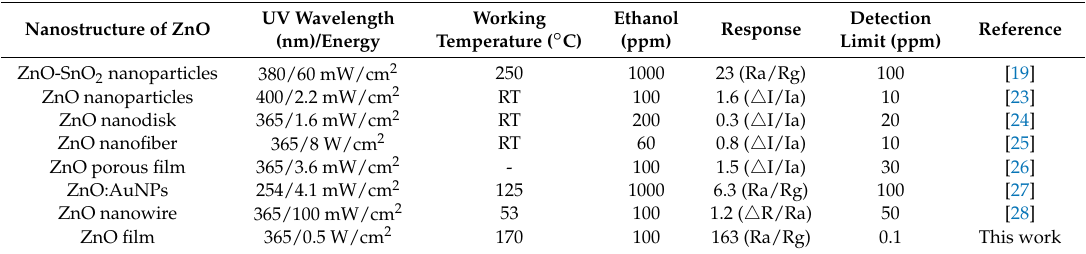
Table 1. Comparison of sensing properties of ZnO sensors with different microstructures under UV